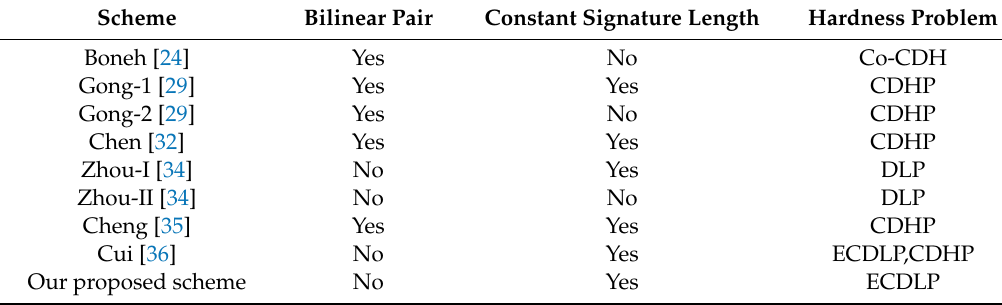
Table 1. The comparison of relevant aggregate signatures.